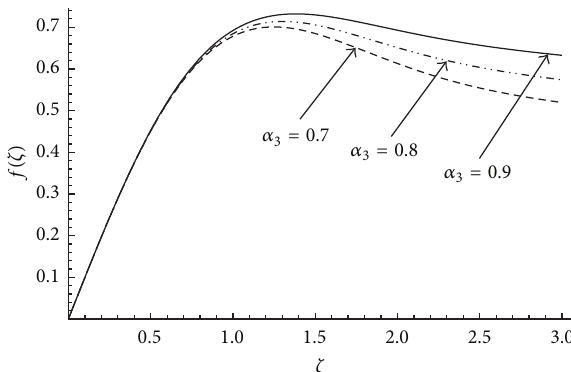
Figure 1: The effect of changing 𝛼 3 on the solution 𝑓(𝜁) at 𝛼 1 = 0.9 , 𝛼